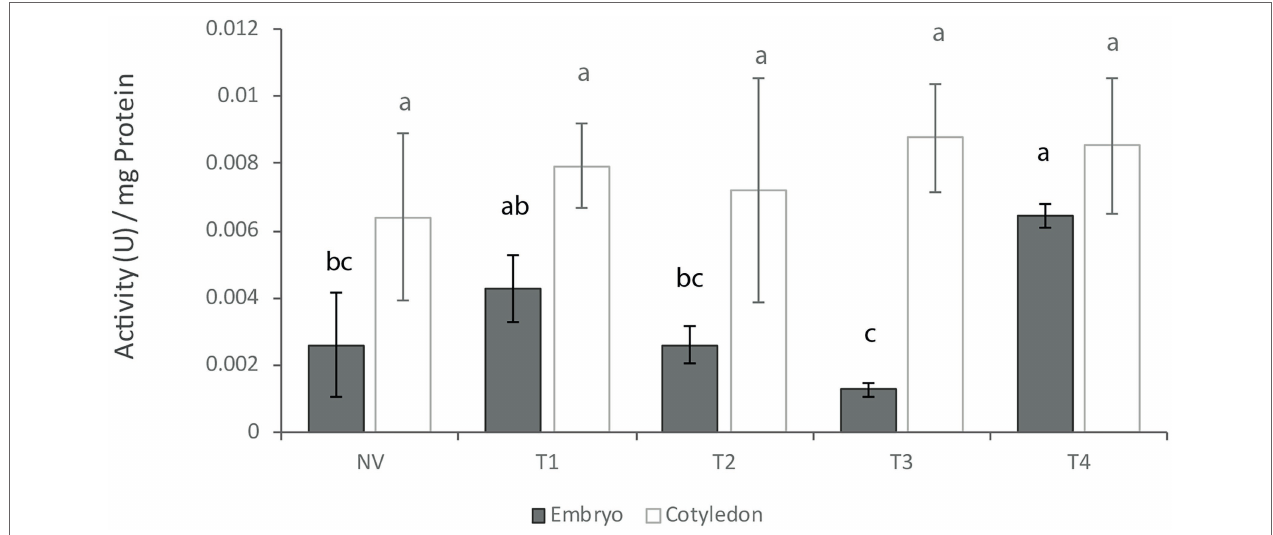
FIGURE 3 | In vitro protease activity at different germination stages. NV: Nongerminated acorns after 4 weeks of germination. T1: mature acorns prior to germination. T2, T3, T4: Germinated acorns when root tips were visibly emerging from cotyledons (T2), their size reached 6.5 mm (T3) and it exceeded 20 mm (T4). Different letters denote significant differences between germination stages in each